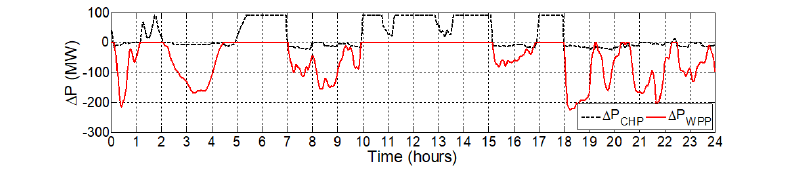
Figure 8. Secondary dispatch from CHP and WPP.